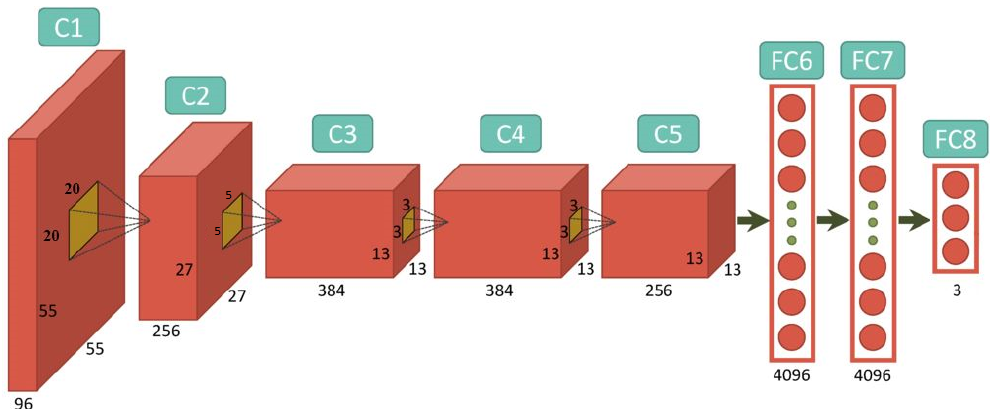
Figure 3. Simplified network